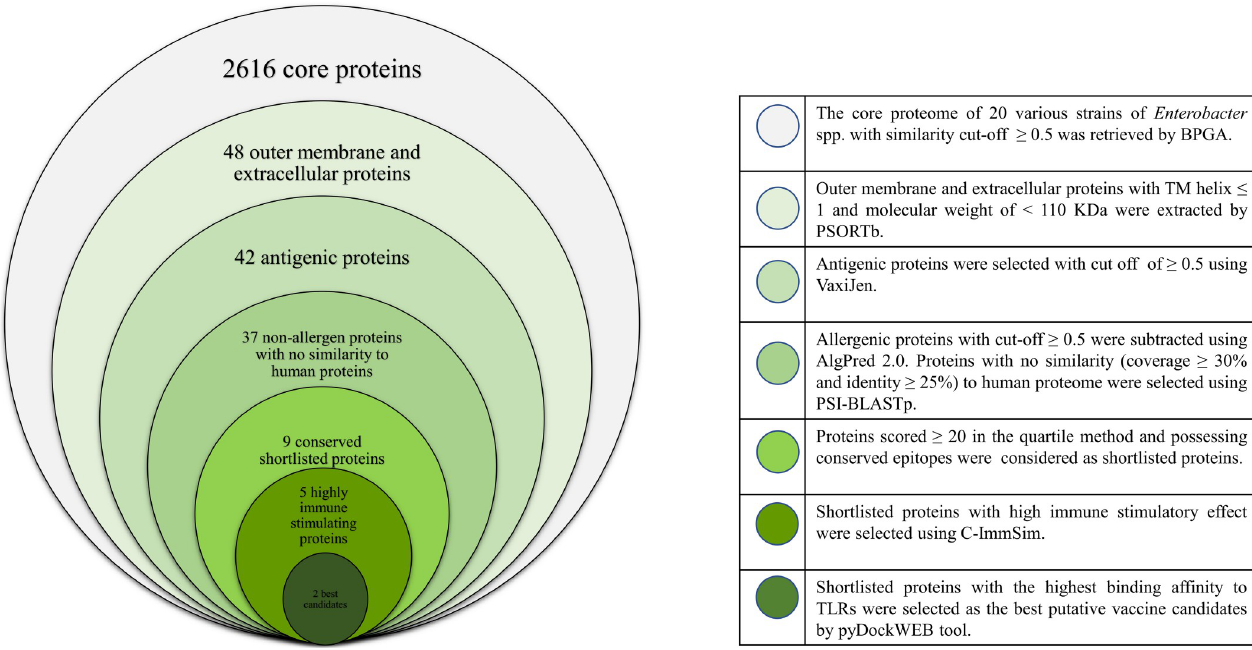
PLOS ONE | https://doi.org/10.1371/journal.pone.0275749 October 13,